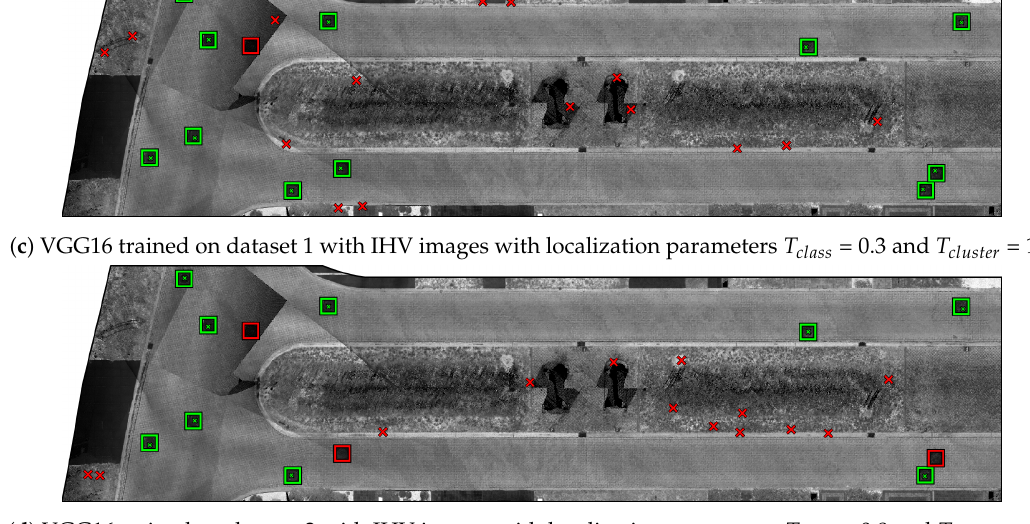
( d ) VGG16 trained on dataset 2 with IHV images with localization parameters T class = 0.8 and T cluster = 11. Figure 7. Visualization of the manhole detection results of the different trained VGG-16 network on a small subsection of the testing dataset. Each square defines the ground truth manhole covers which are colored green when detected and red when undetected. The predicted manhole cover positions are indicated by the crosses. A green cross indicates a true positive detection while a red cross indicates a false positive. The location parameters (classification threshold T class and cluster threshold T cluster ) are in the caption of each image. Table 5. Summary of the object detection results (recall, precision and F 2 -score) with the corresponding classification threshold T class and cluster threshold T cluster when only considering the detection on the road surface. The results and optimal parameters are displayed for both the maximal F 2 -score and maximal recall